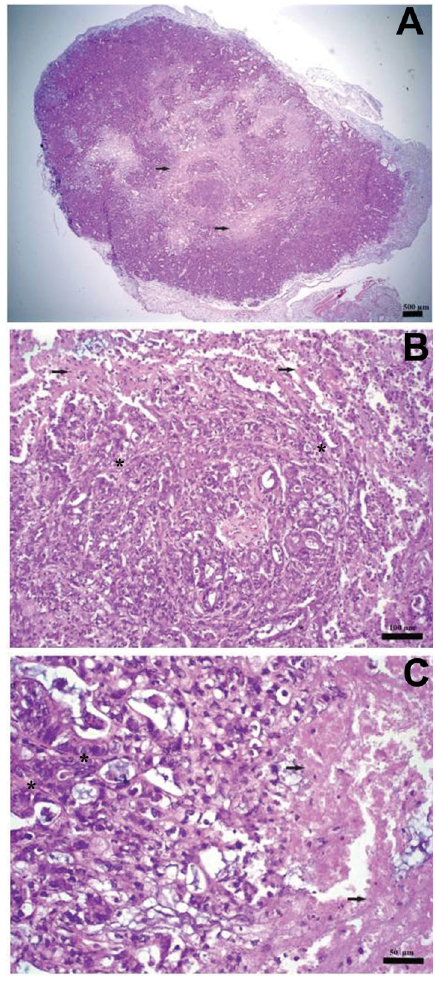
Figure 1. Pancreatic adenocarcinoma experimental model at 25 days after inoculation of the human ductal Capan-1 cell line into nude male BALB/c mice. Tumor histological section images, hematoxylin and eosin staining. A , 2 (cid:3) , scale bar: 500 m m; B, 20 (cid:3) , scale bar: 100 m m: C , 40 (cid:3) , scale bar: 50 m m. Arrows indicate areas of necrosis and the asterisks represent conjunctive